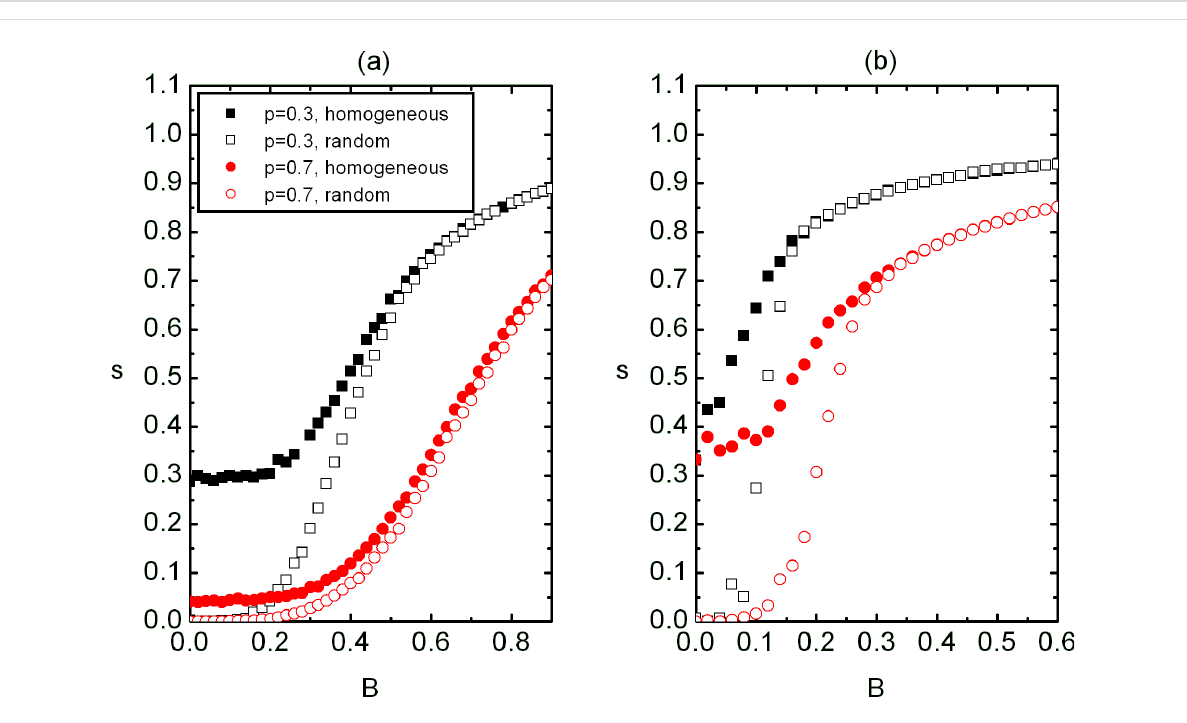
Figure 3: The s ( B ) dependence for homogeneous and random samples for two different p in (a) 2D and (b) 3D. For s ( B = 0) we obtain s (ran) = 0. In the disordered regime it holds s (hom) > s (ran) and s (hom) ≈ s (ran) in the ordered regime. (a) W = 2.5, N 0 = 260; (b) W = 2.5, N 0 = 100. The legend is shown in